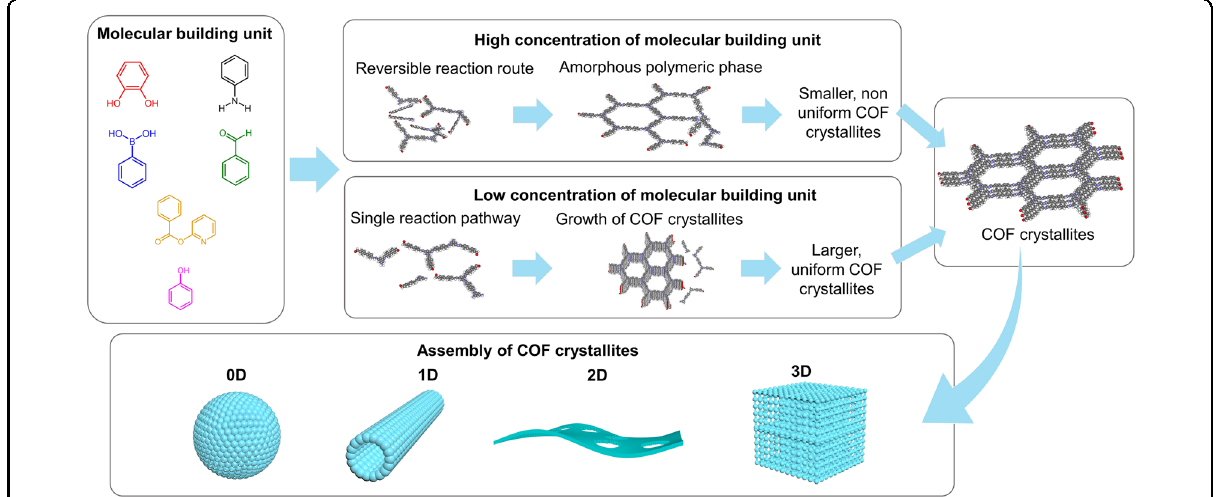
Fig. 4 Fundamental concept of the synthesis of a covalent-organic framework (COF). COF are crystalline porous materials fabricated from molecular building units that are connected through covalent bonds. By controlling the assembly of molecular building blocks, it enables the synthesis of porous structures and ability to adjust the physicochemical properties of